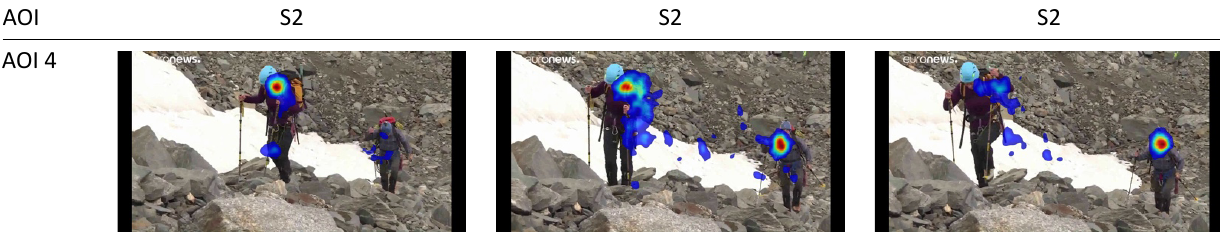
Table 7. Heat maps of the stimuli. AOI